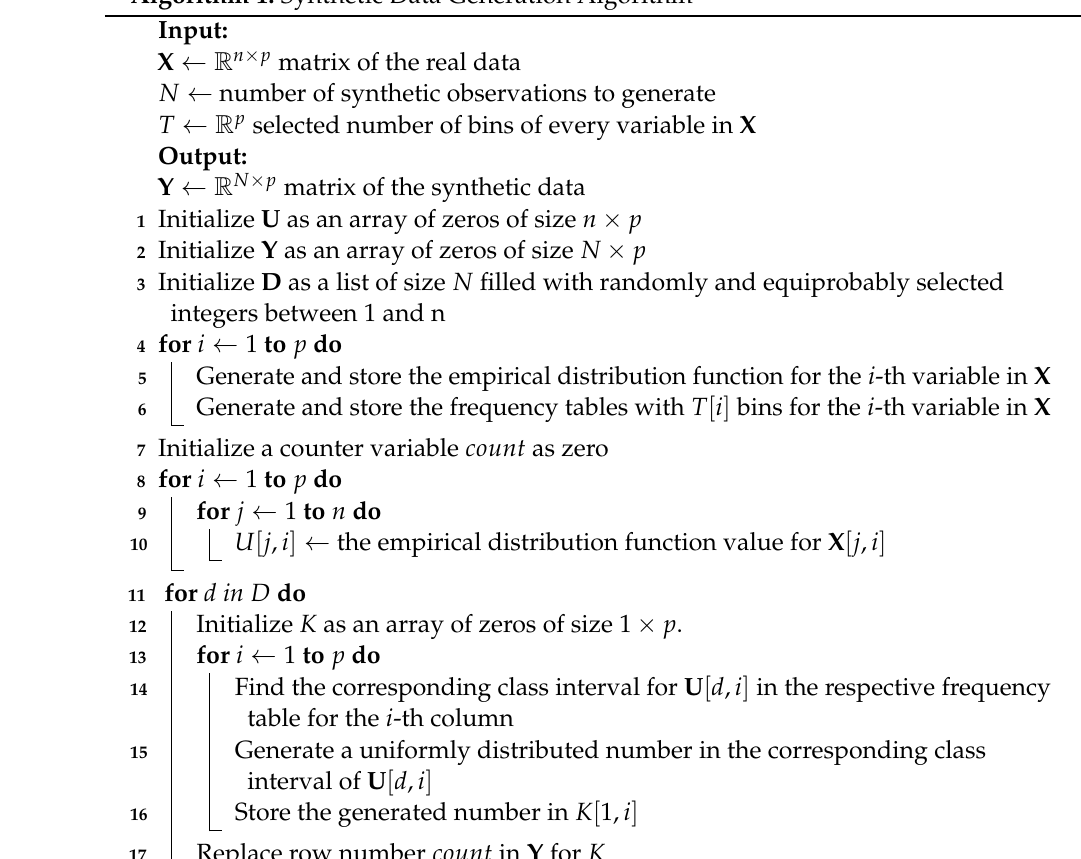
Algorithm 1: Synthetic Data Generation